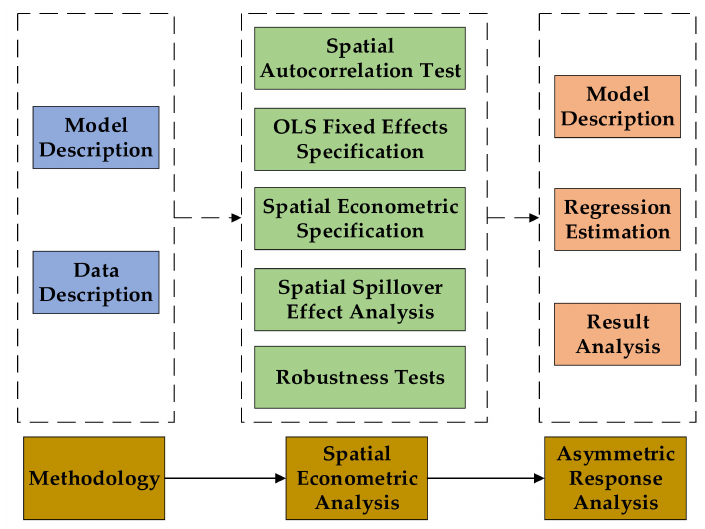
Figure 1. Research framework and